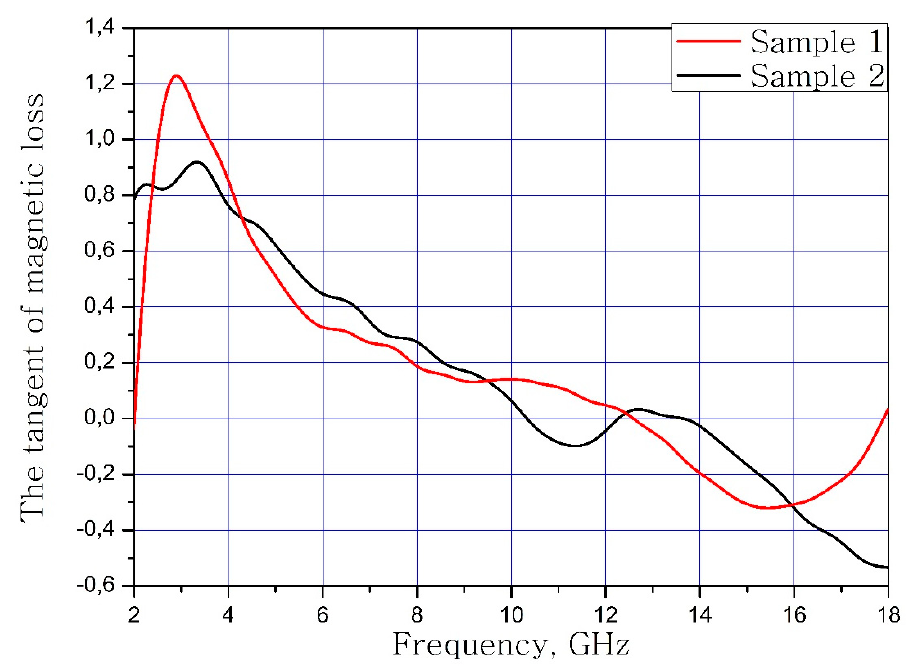
Nanomaterials 2019 , 9 , x FOR PEER REVIEW Figure 7. Frequency dependence of the dielectric loss tangent of samples. Figure 7. Frequency dependence of the dielectric loss tangent of samples.